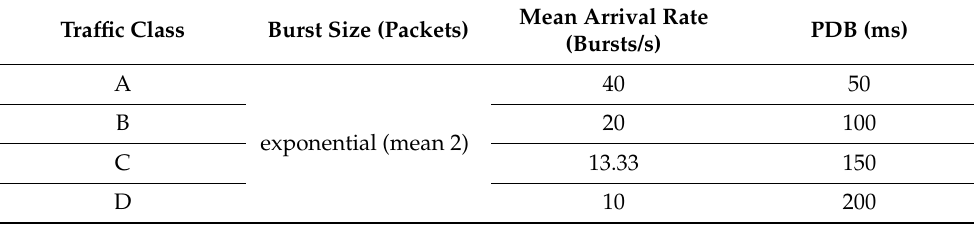
Table 3. Traffic Model for Power Saving with